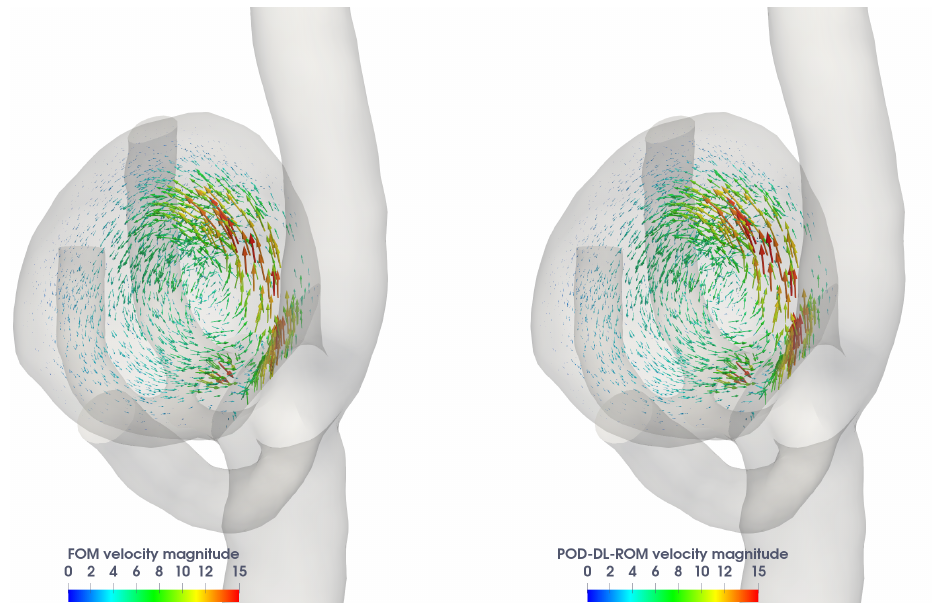
Figure 16. Test case 3: FOM ( left ) and POD-DL-ROM ( right ) velocity field magnitude for the testing- = ( 5.9102,3.1179 ) at t = 0.18 parameter instance µ test